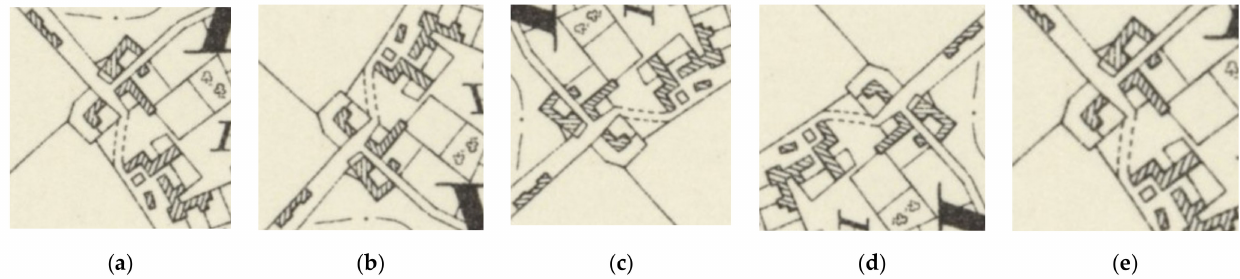
Figure 3. Training data set. ( a ) Original image; ( b ) image after flipping vertically; ( c ) image after rotating 270 ◦ ; ( d ) image after rotating 90 ◦ ; ( e ) image after random